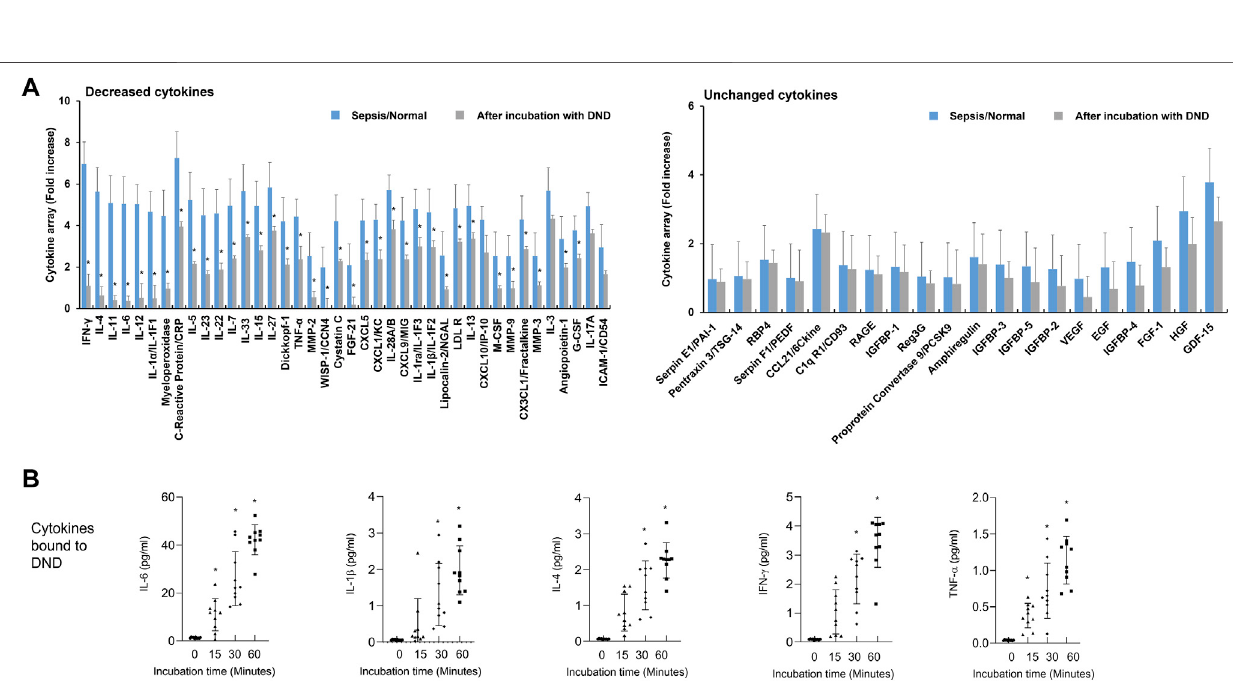
Frontiers in Bioengineering and Biotechnology |